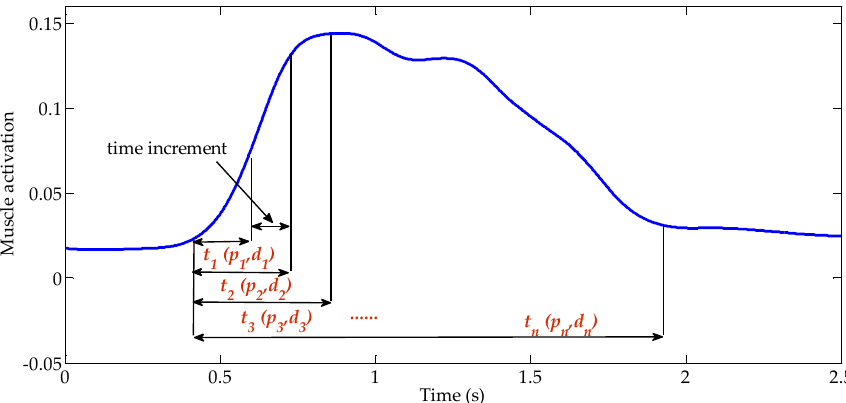
Figure 3. Schematic diagram of the proposed time-increasing searching method. The reflex model is applied to fit the muscle activation step by step to find a proper reflex-domain time interval.